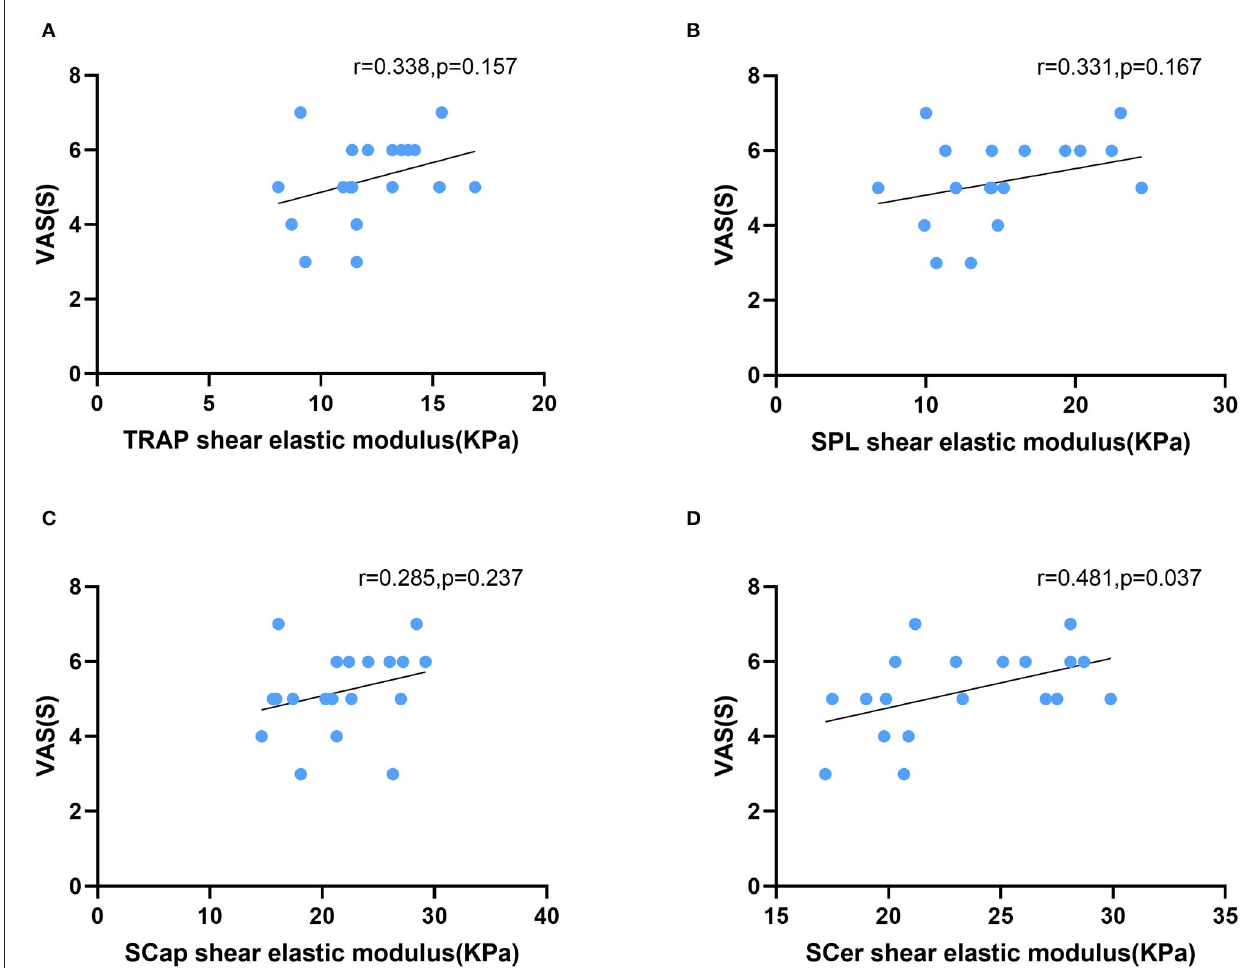
FIGURE 3 | Correlation between superficial cervical extensor muscle stiffness and VAS scores in patients with CEH. The stiffness of SCer (D) was positively correlated with VAS scores. The stiffness of TRAP (A) , SPL (B) , and SCap (C) was not correlated with VAS scores. TRAP, trapezius; SPL, splenius capitis; SCap, semispinalis capitis; SCer, semispinalis